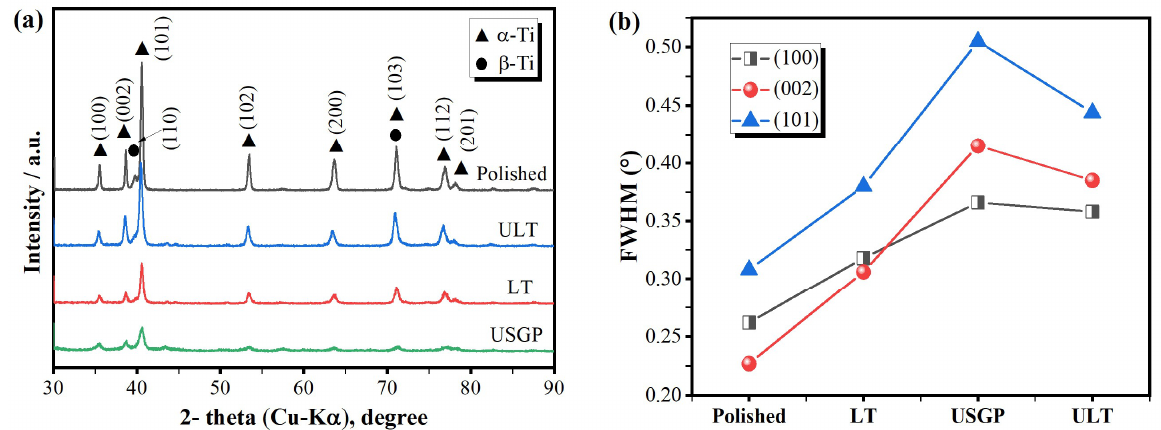
Figure 5. X-ray diffraction pattern ( a ), the variation of FWHM of α (100), (002), and (101) peaks ( b ) of overall treated samples before sliding wear.